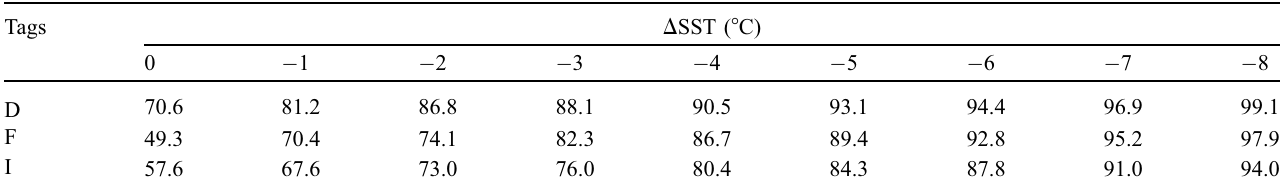
Table 3. Cumulative percentage of deviates of the ambient temperature of yellow fi n tuna and daily mean sea surface temperature (SST) which was calculated following Nielsen et al. (2006) and is analogous to Brill et al. (1993). Tags D SST ( °